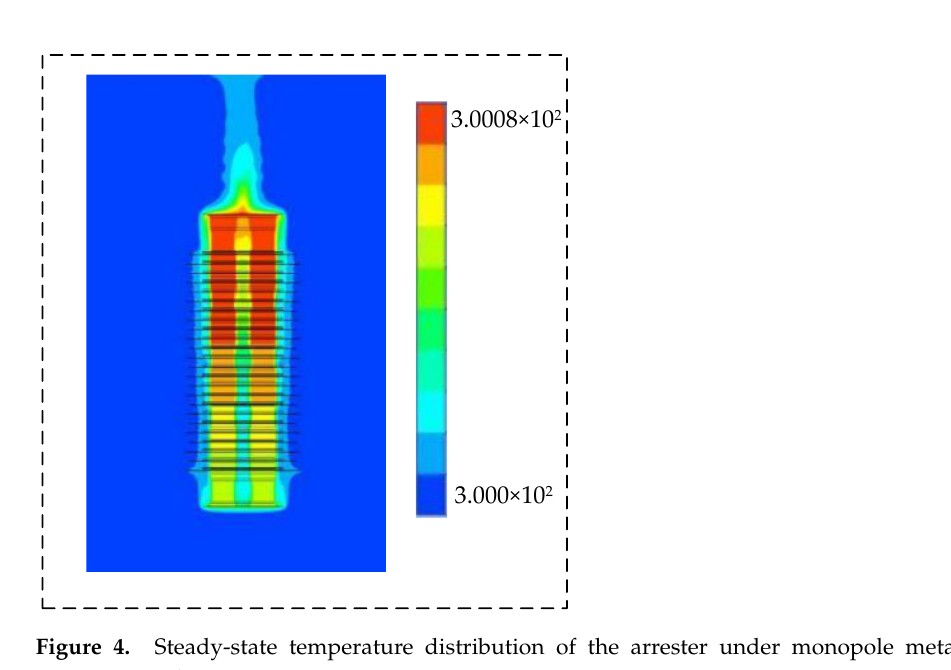
Figure 4. Steady-state temperature distribution of the arrester under monopole metal loop operation mode.